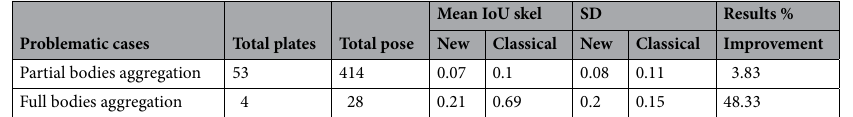
Table 2. Summary of the comparison of automatic methods with the second IoU index. This table offers the results obtained from the connected bodies poses included in the validation dataset using the second IoU index for each problematic case. Values reveal the percentage of how connected they were to one another (See the Supplementary Material for more details).